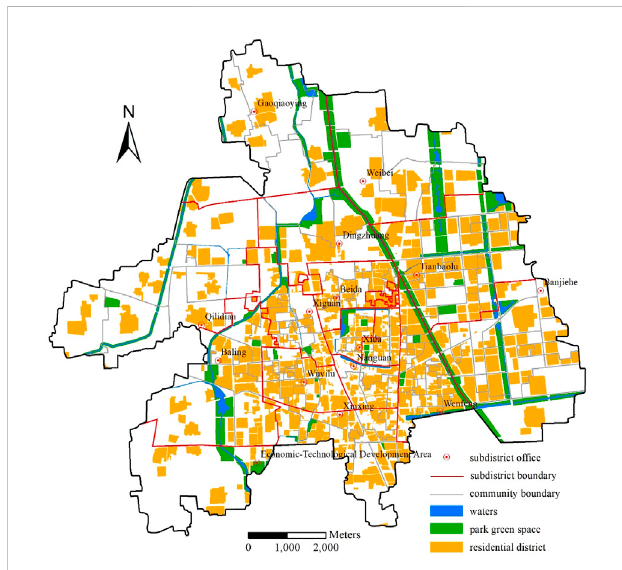
FIGURE 2 Distribution of subdistrict, community, and residential quarter and parks in the study